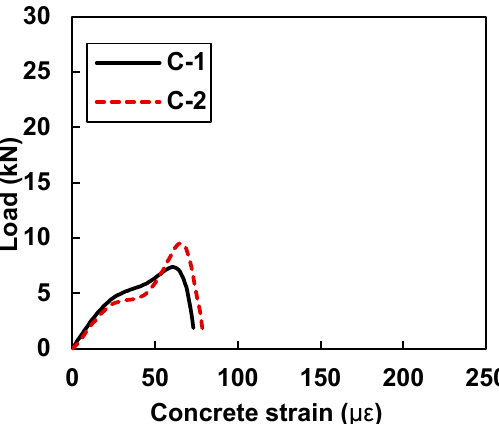
Figure 12. Load vs. concrete strain for samples C-1 and C-2.